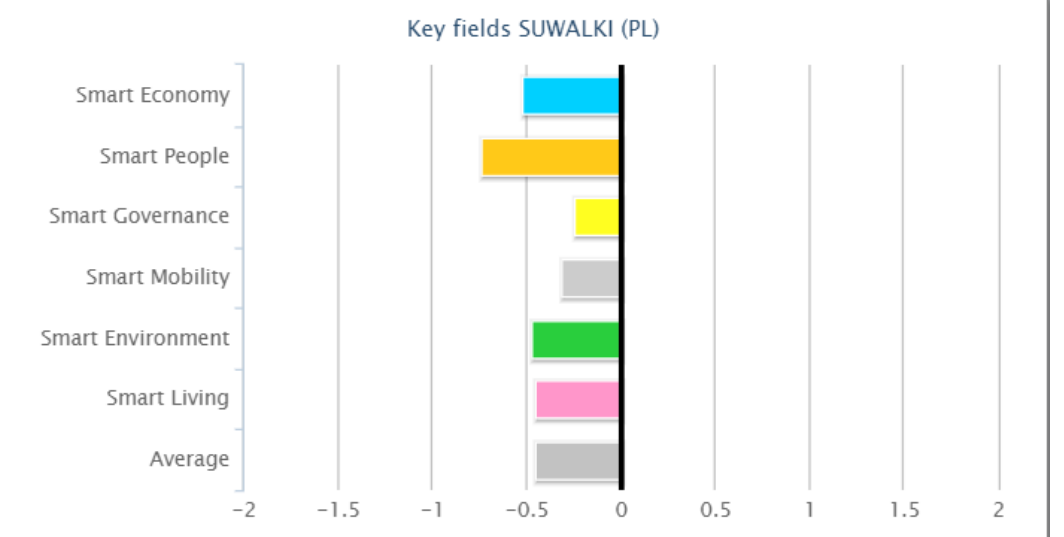
Figure 3. City profile: Suwalki (PL). Source: http://www.smart-cities.eu (accessed on 10 January 2023).